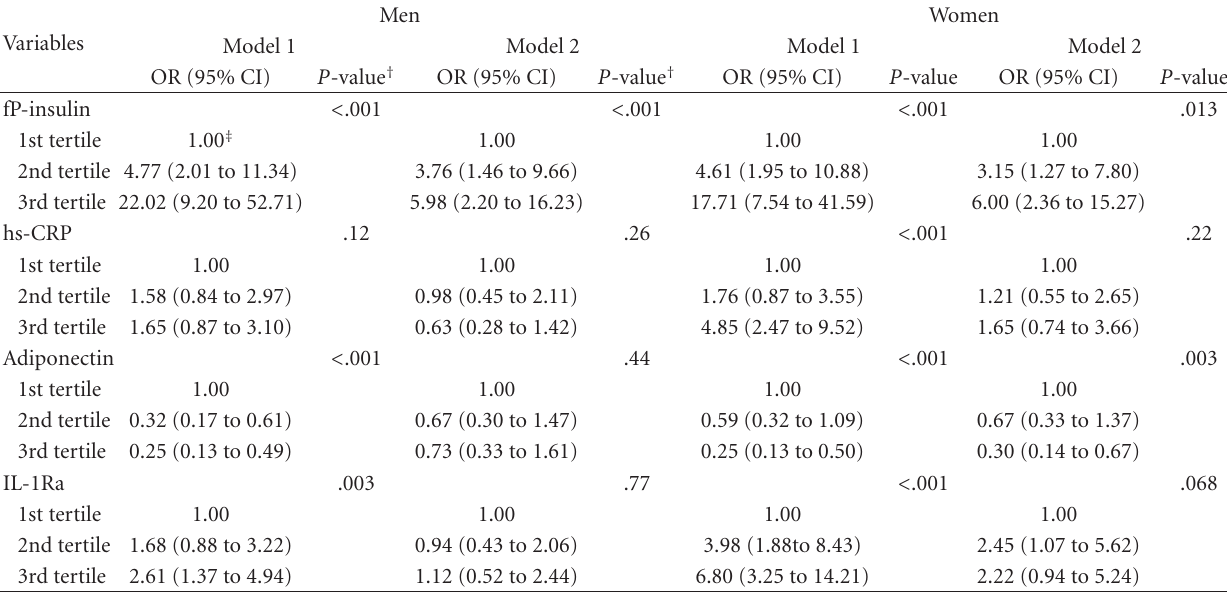
Table 3: Odds ratio (OR) for the presence of metabolic syndrome defined by the NCEP criteria according to the gender-specific tertiles of insulin, C-reactive protein, adiponectin and interleukin-1- receptor antagonist in men and women in two adjusted models.